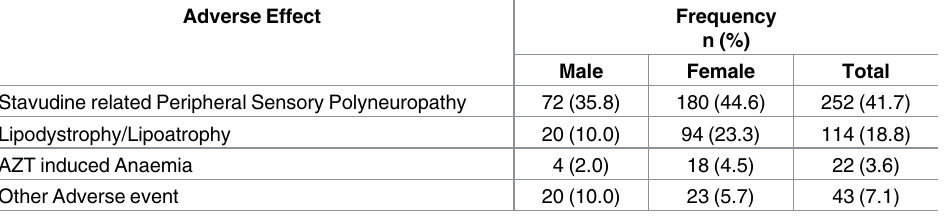
Table 2. Frequency of treatment adverseeffectsexperienced during follow-up (N =